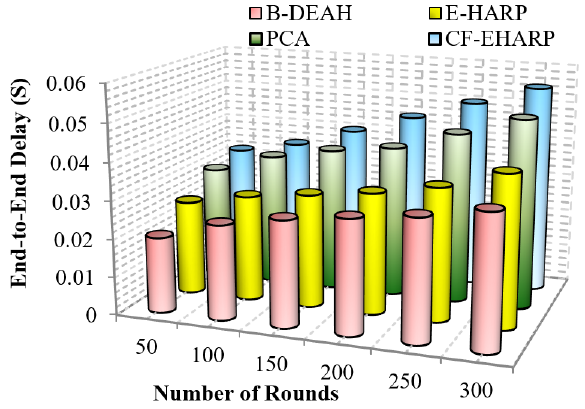
Figure 10. End-to-end delay vs. simulation rounds (emergency packets).